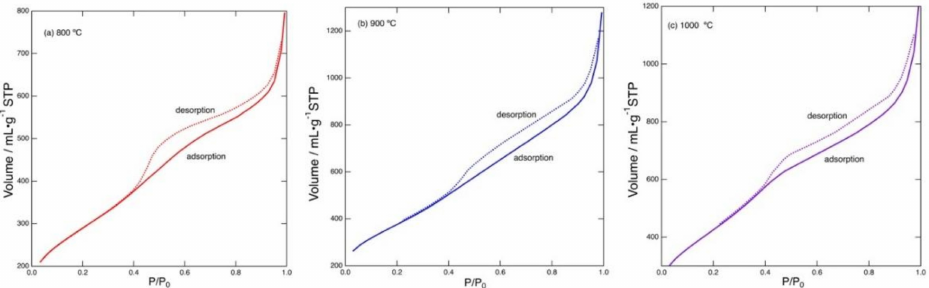
Figure 4. Adsorption and desorption isotherms of the carbonized products prepared by heating at ( a ) 800 ◦ C, ( b ) 900 ◦ C, and ( c ) 1000 ◦